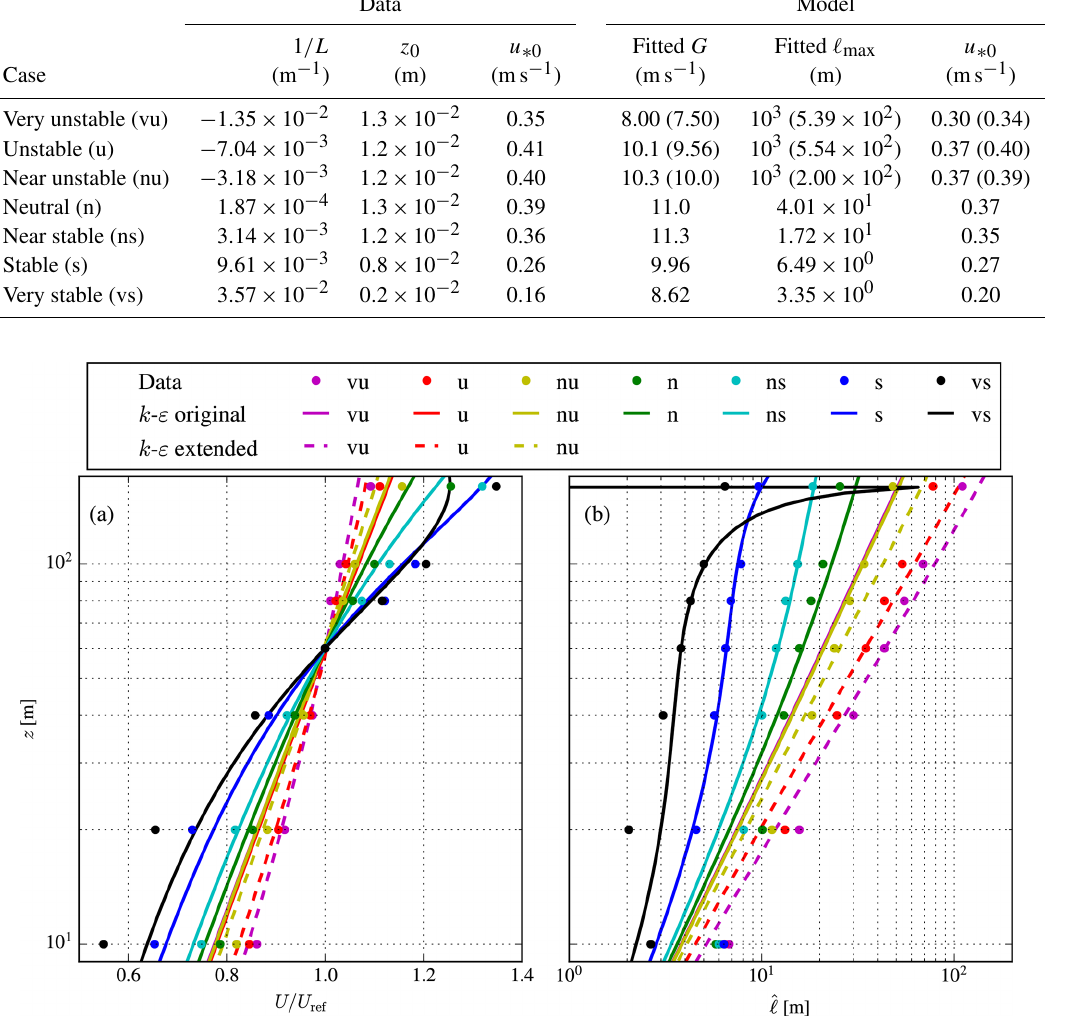
Figure 8. ASL measurements of Peña et al. (2010) compared to simulation results of the original limited-length-scale k – ε model of Apsley and Castro (1997). (a) Wind speed. (b) Turbulence length scale from Eq. (29). Unstable cases are also simulated with our extension to unstable surface layer stratification with L from Table